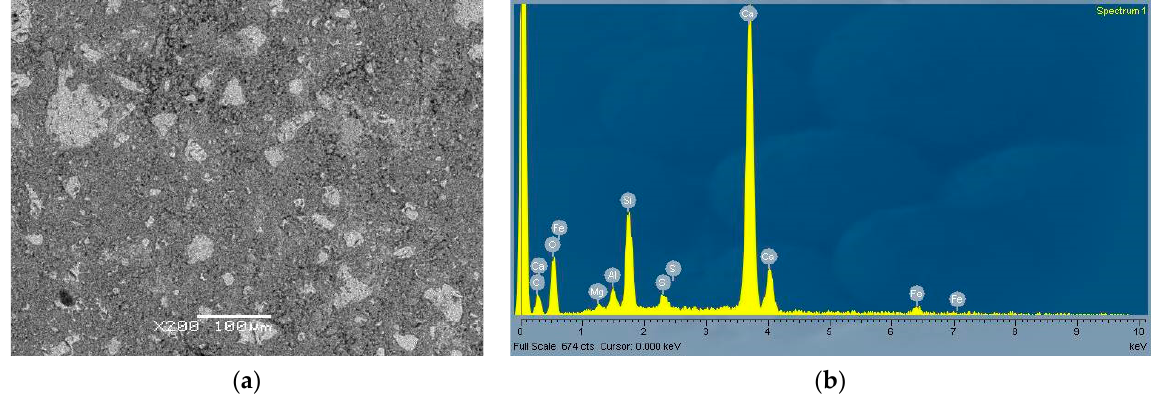
Figure 5. SEM image of cement paste—CEM ( a ) with corresponding EDS ( b ).